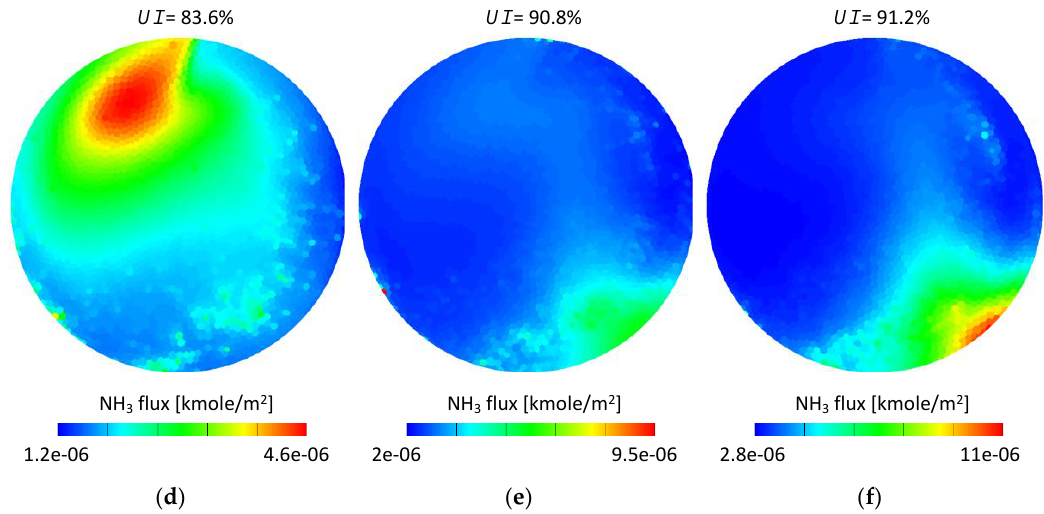
Figure 13. Time integrated NH 3 molar flux scaled to the cell face area-12 mm from the SCRF inlet: ( a ) 100 kg/h set-up #1; ( b ) 200 kg/h set-up #1; ( c ) 300 kg/h set-up #1; ( d ) 100 kg/h set-up #2; ( e ) 200 kg/h set-up #2; ( f ) 300 kg/h set-up #2.